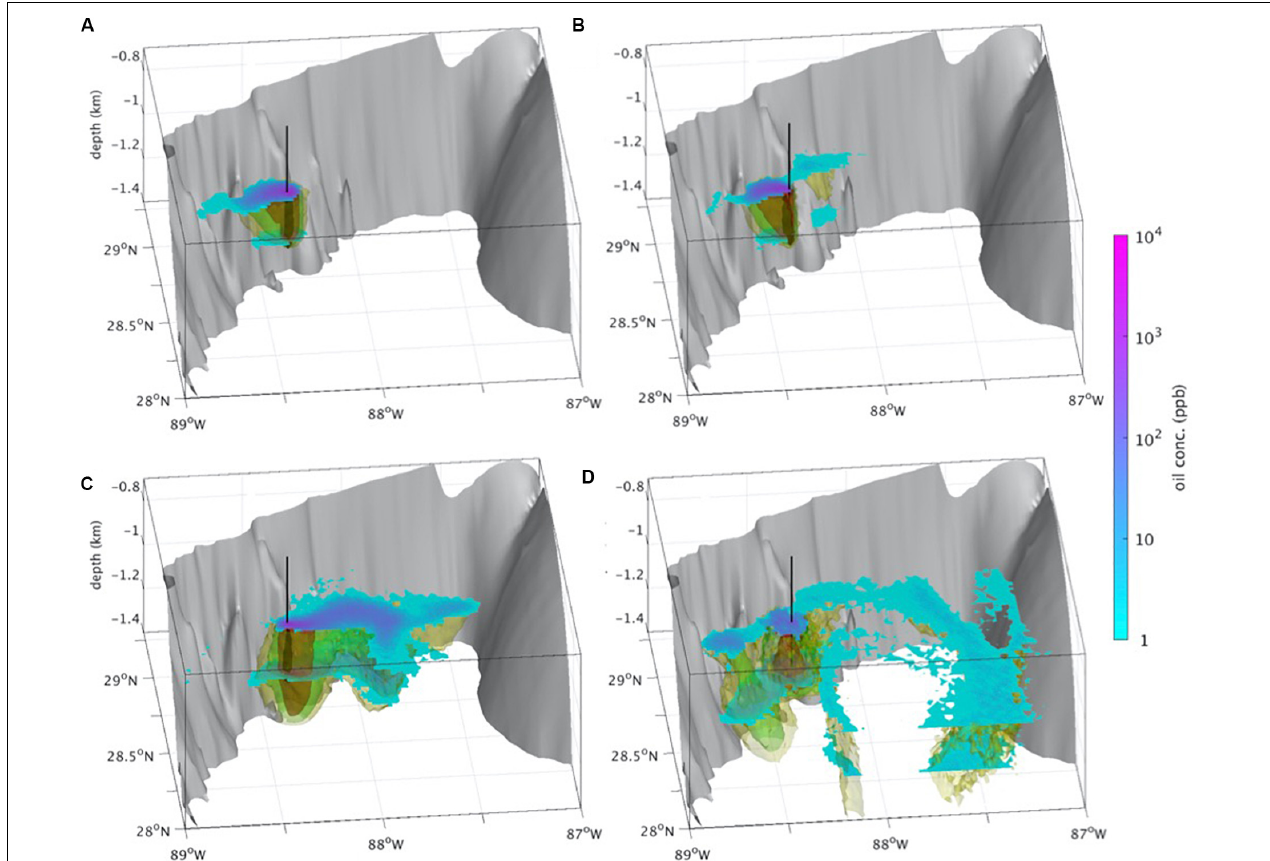
FIGURE 5 | The Deepwater Horizon (DWH) deep plume model: 3-D evolution of the oil concentrations in the deep plume during (A) May 5th, 2010 (day 15); (B) May 30th, 2010 (day 41), (C) June 30th, 2010 (day 73), (D) July 29th, 2010 (day 100). Isosurfaces of the daily average subsea oil concentrations of 1000 ppb (black), 100 ppb (orange), 10 ppb (green), 1 ppb (yellow). Concentration layer gradients are plotted at 1,000 and 1,200 m, bounding the deep plume. Gray isosurface represents the bathymetry, and black line marks the axis of the Macondo well ’s coordinates. The deep plume propagates initially toward the southwest until the end of May (A) ; it then oscillates and spreads along a southwest-northeast axis from Macondo, following bathymetric features (B) ; toward the end of June the core concentrations of the deep plume switch toward the northeast, and the plume penetrates the De Soto Canyon (C) ; through July the plume oscillates again and the core concentrations are transported to the southwest, while the northeast branch continues to disperse (D) ; this pattern was observed in Kessler et al. (2011). In addition, the 3D plume model shows strong subduction moving the plume high concentrations (i.e., 100 ppb) down to 1400 m. The simulations for this figure used the oil-CMS (Paris et al., 2012) algorithm, where 3,000 droplets were released every 2 h at the trap-height (i.e., 1222 m) above the wellhead from April 20th to July 15th, 2010, after which oil was tracked until July 28th (i.e., the simulation lasted 100 days). The initial DSD was simulated with a log-normal function (mean µ = 70 µ m and θ = 0.62), the pseudo-component composition and fate is from Perlin et al. (2020). Oil was dispersed using two implementations of GoM-HYCOM to better capture the vertical transport during the DWH (Paris et al., 2012): HyCOM expt. 20.1 until July 14th, and HyCOM expt. 31.0 from July 15th to October 31st. A random walk component simulates sub-gridscale processes with horizontal and vertical turbulent diffusivity coefficients set to 1 m 2 s − 1 and 10 − 5 m 2 s − 1 ,